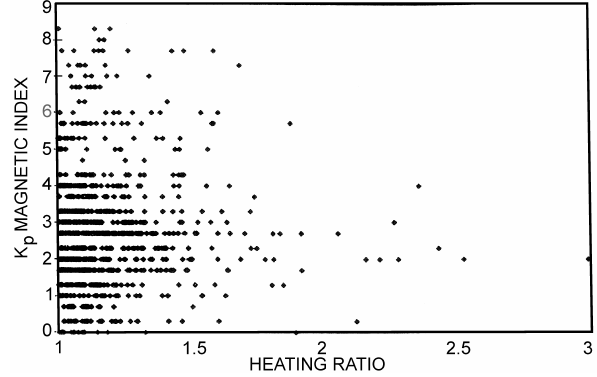
Fig. 3. (cid:15) 6 as a function of the 10.7 cm solar radio flux. Fig. 4. (cid:15)